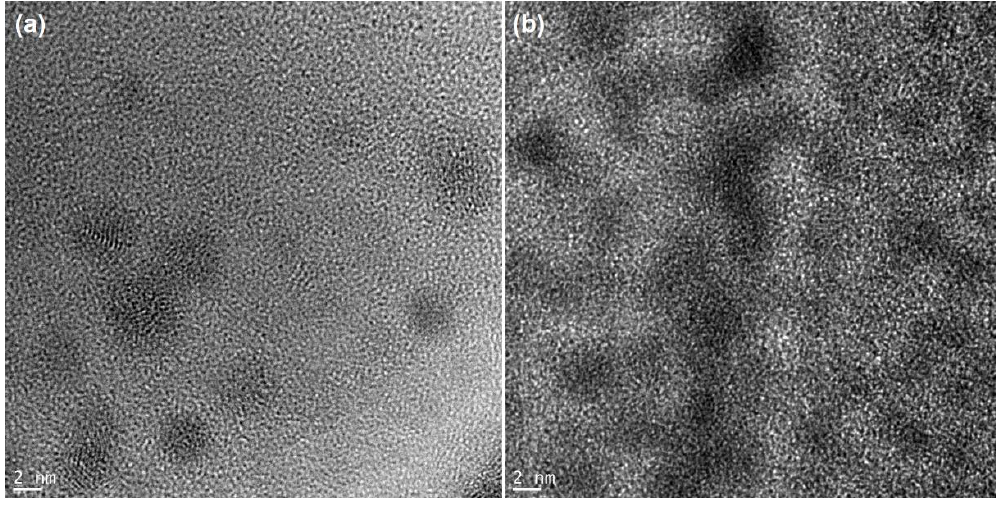
Figure 2. High-resolution transmission electron microscopy (HRTEM) cross-sectional image of the as-deposited thin films, ( a ) GeO[SiO 2 ] and ( b ) GeO[SiO].